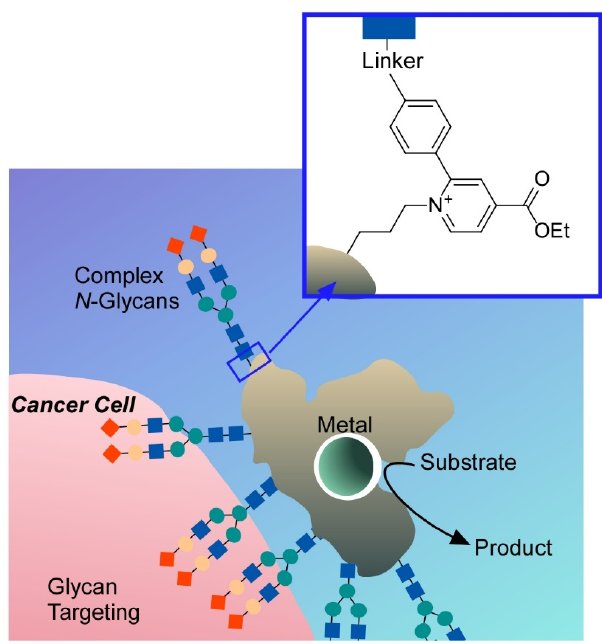
Figure 27. Nanoarchitectonics of artificial metalloenzyme on the basis of glycosylation of proteins.